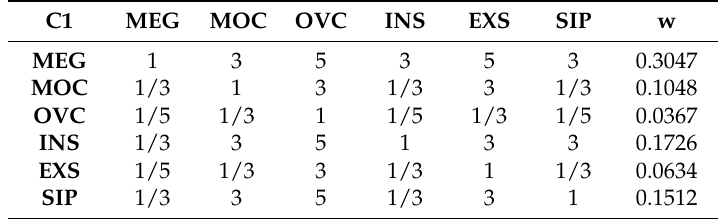
Table 4. Comparison of the six alternatives with regards to effectiveness (C1).